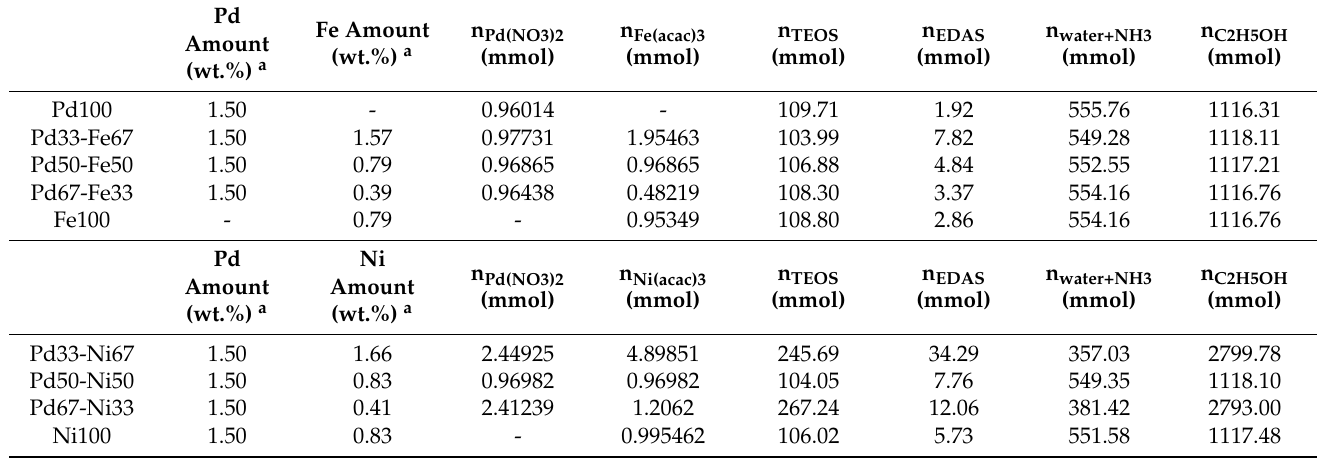
Table 1. Operating synthesis variables for the catalysts Pd-Fe/SiO 2 et Pd-Ni/SiO 2 .